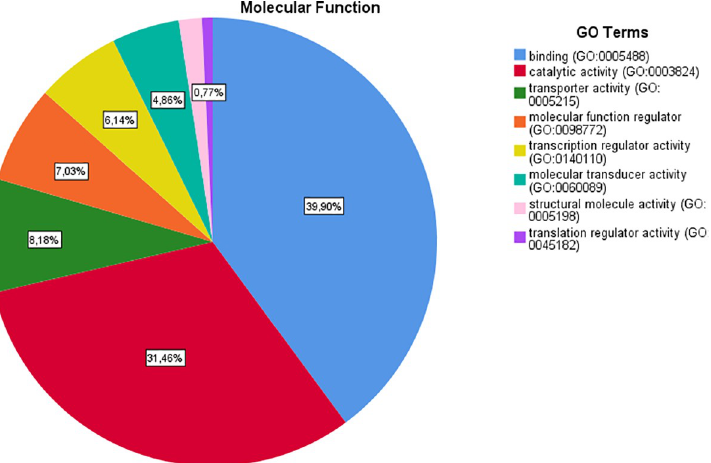
Fig 2. Results of “molecular function” category.